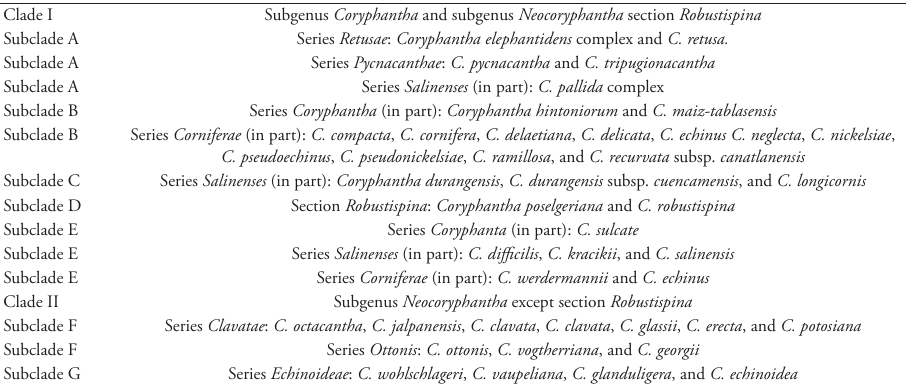
Table 3. Species memberships of the main clades obtained in this study and their previous infrageneric classification by Dicht and Lüthy